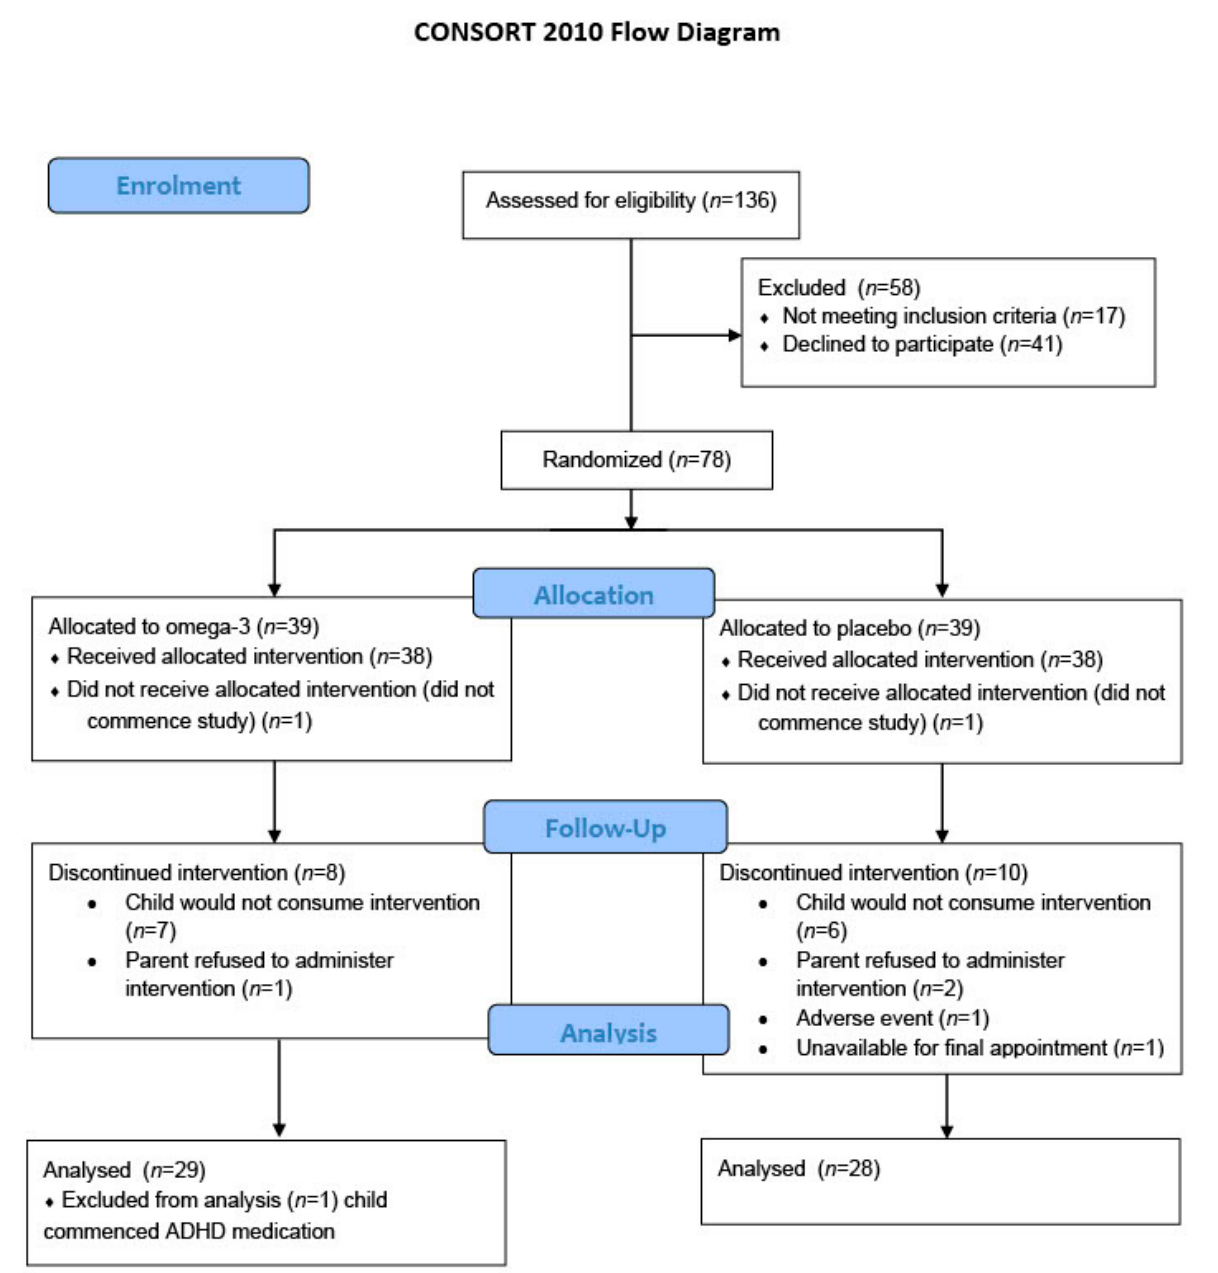
Figure 1. CONSORT